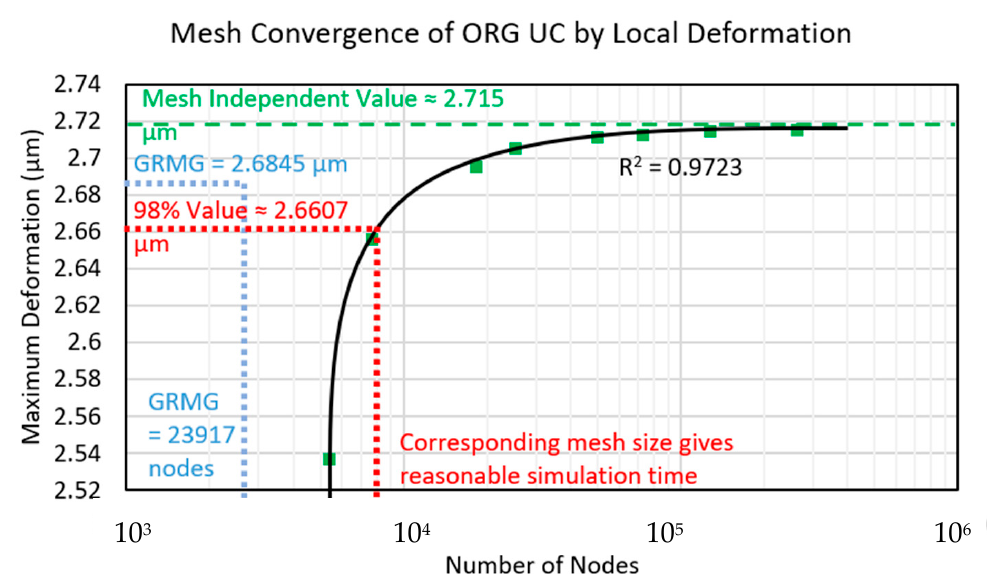
Figure 17. Results of mesh convergence for ORG UC using local deformation as the driving param- eter.